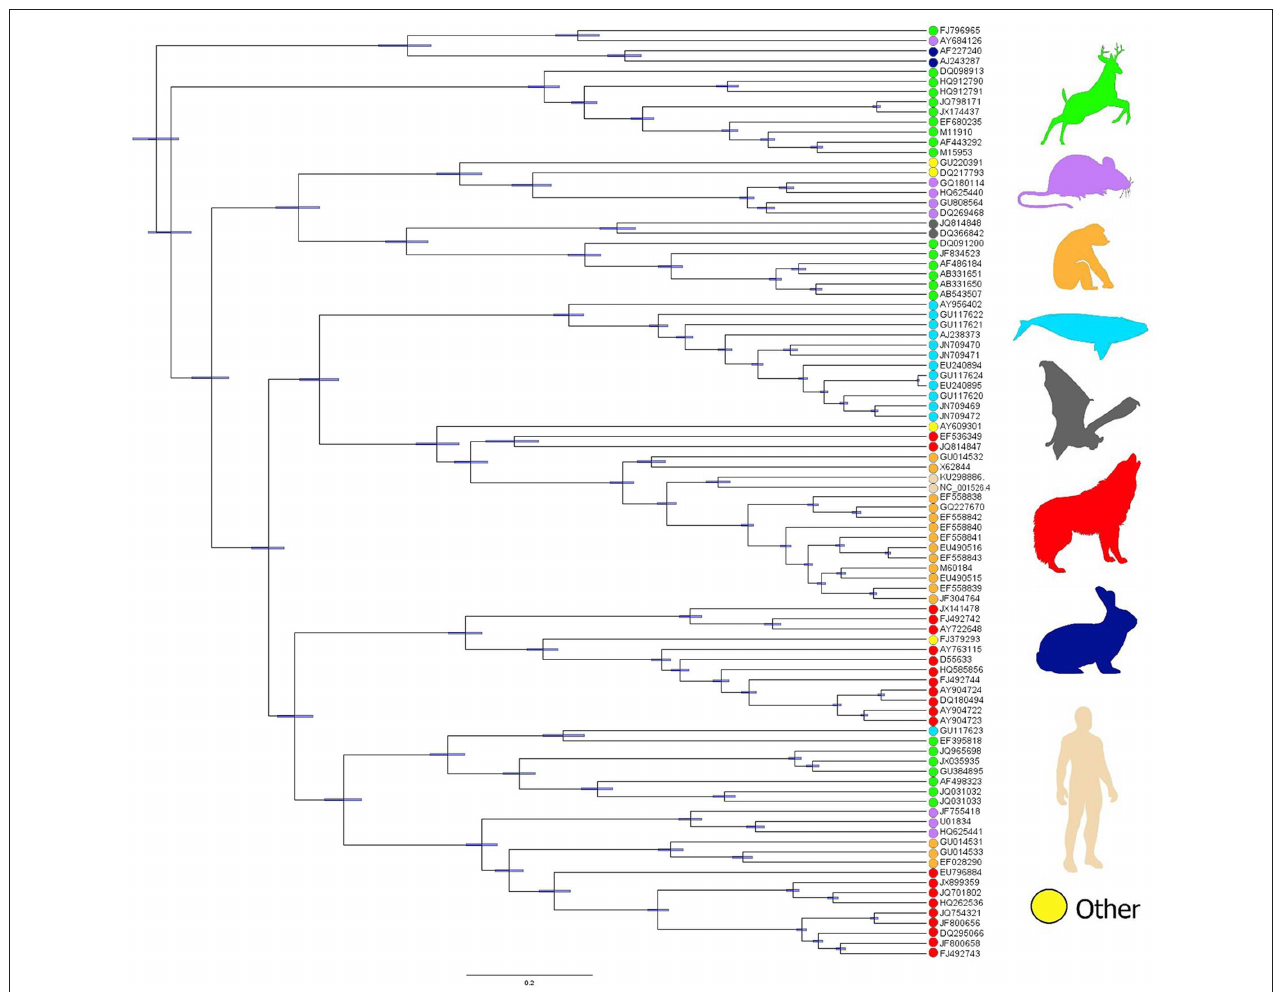
FIGURE 3 | Phylogenetic distribution of WPV lineages in mammals. Dots denote the host species reported according to each WPV lineage. Green: ungulates; purple: rodents; orange: apes: light blue: cetaceans; gray: bats; red: carnivores; dark blue: rabbits (lagomorphs); light pink: humans; yellow: other hosts (FJ379293: hedgehog; AY609301: manatee; GU220391: